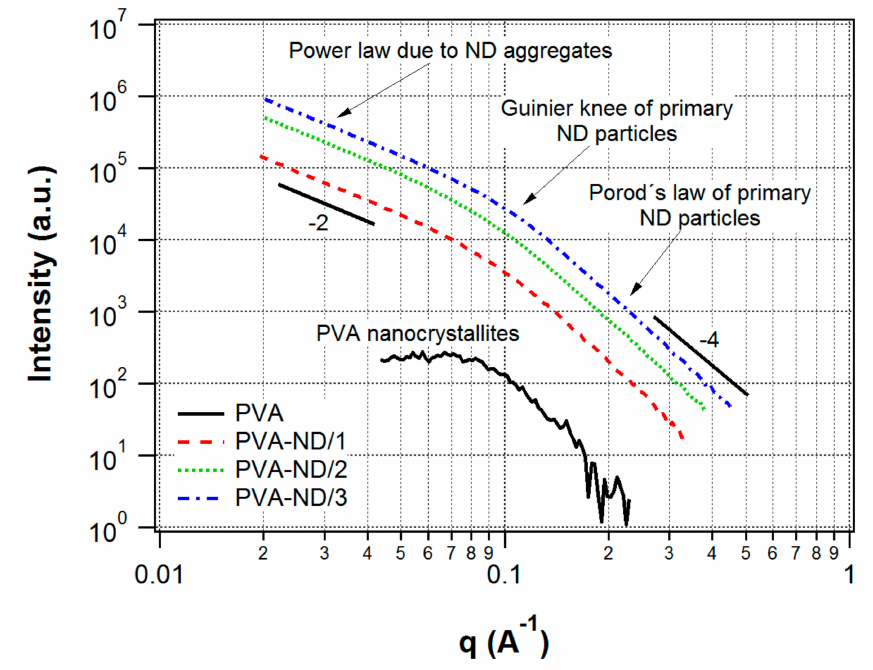
Figure 4. SAXS profiles of the pure PVA film and the